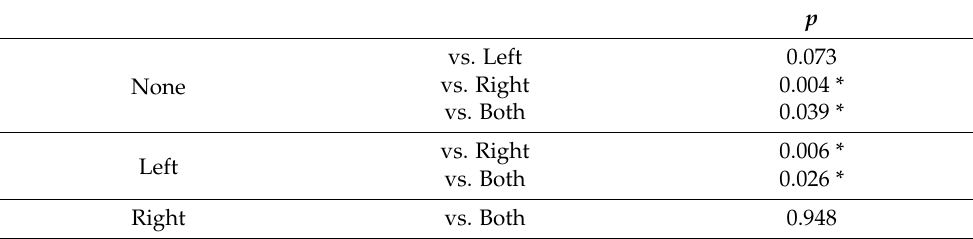
Table 5. Subgroup analysis of CFS dominance divided by total counts of CFS ≥ grade 3 on left and right sides and arm pain sidedness.